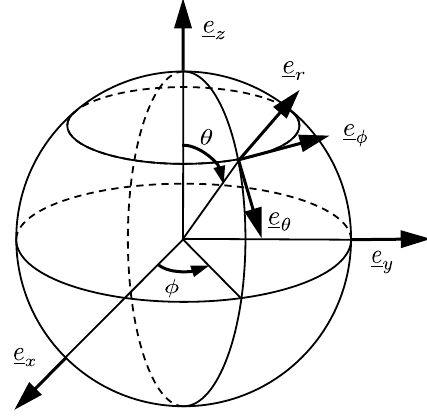
Figure 3. Local spherical coordinate system covering the inclusion